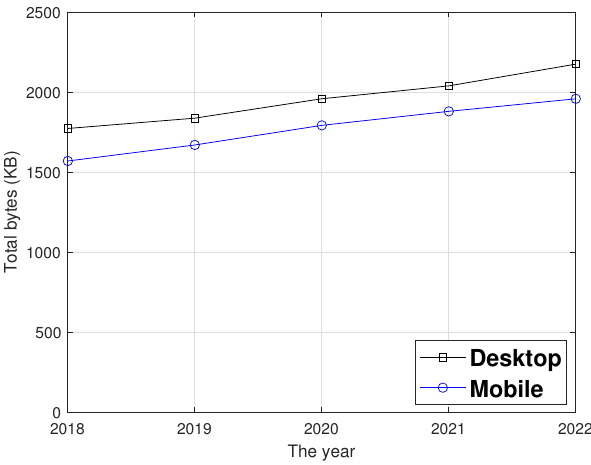
Figure 1. Median web page size.